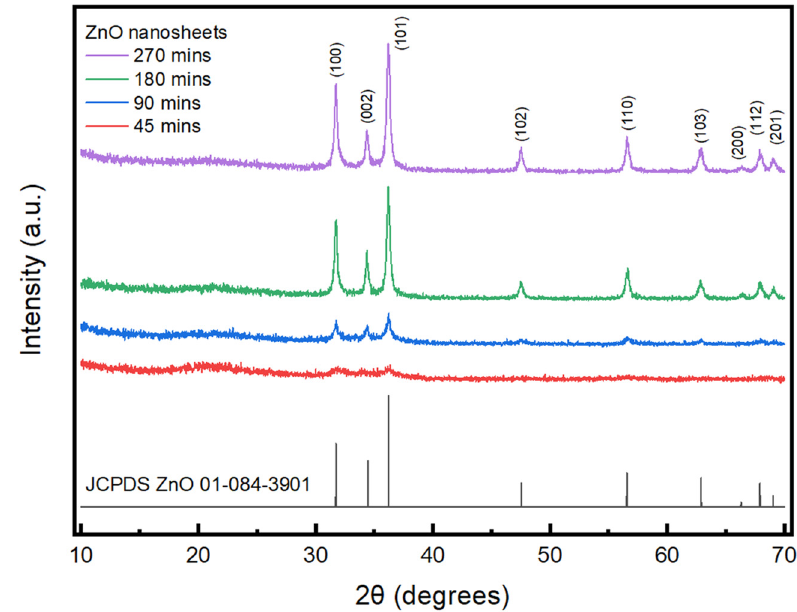
Figure 3. XRD image of ZnO nanosheets at different growth